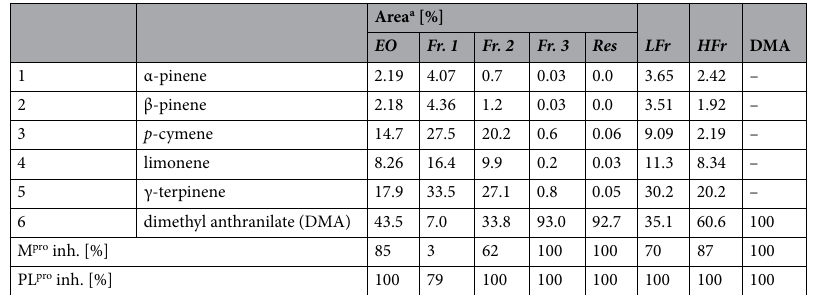
Table 3. Discovery of the most active constituents of the petitgrain mandarin ( Citrus reticulata blanco var. Mandarin) oil against SARS-CoV-2 M pro and PL pro . a Area percentages of the main components of the petitgrain mandarin oil and its fractions: Fr. distillation fraction number, Res. distillation residue, EO essential oil, LFr light fraction of the oil, HFr heavy fraction of the oil.